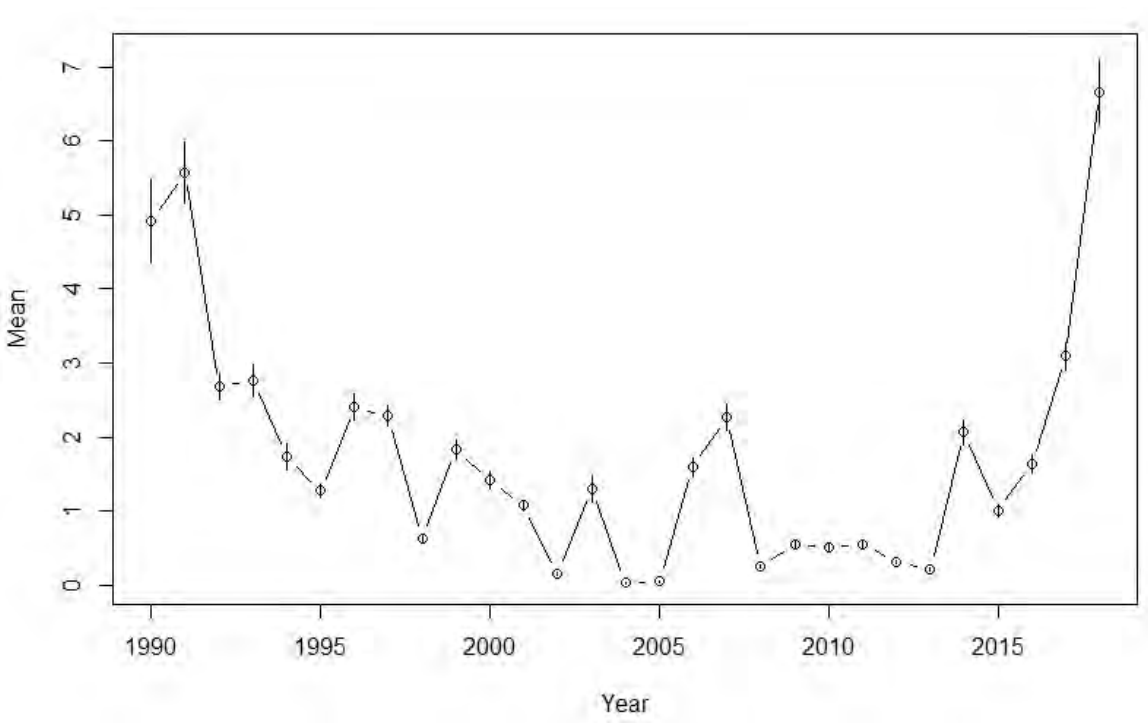
Figure 55. Delaware Fish and Wildlife Adult Trawl Survey abundance index for all adult male horseshoe crabs in spring (March through August).